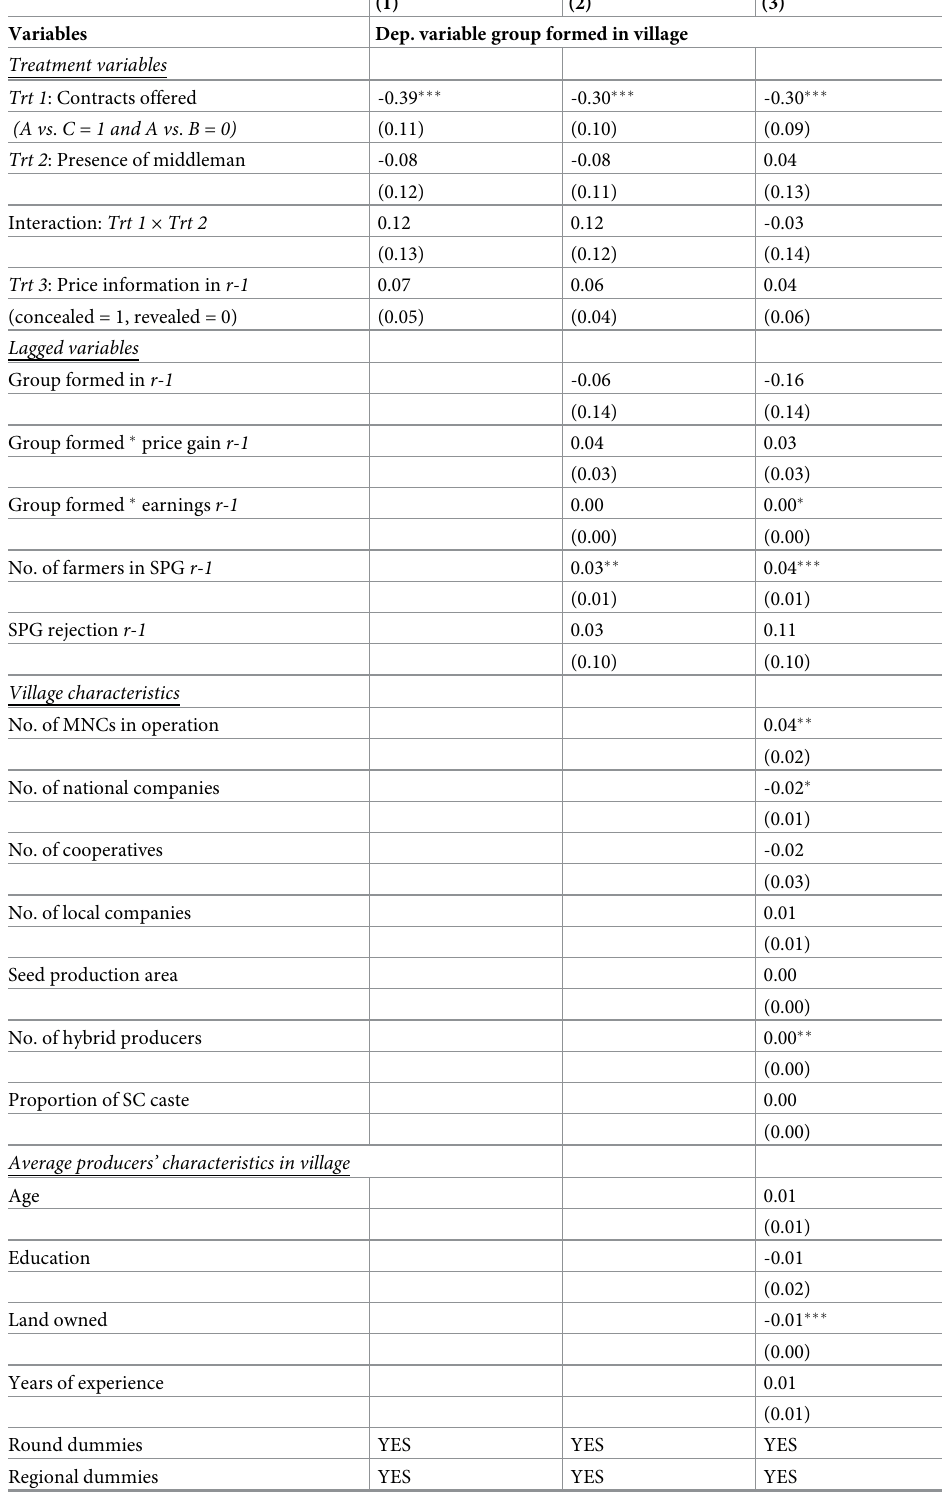
Table 6. Determinants of the formation of a seed producer group in the